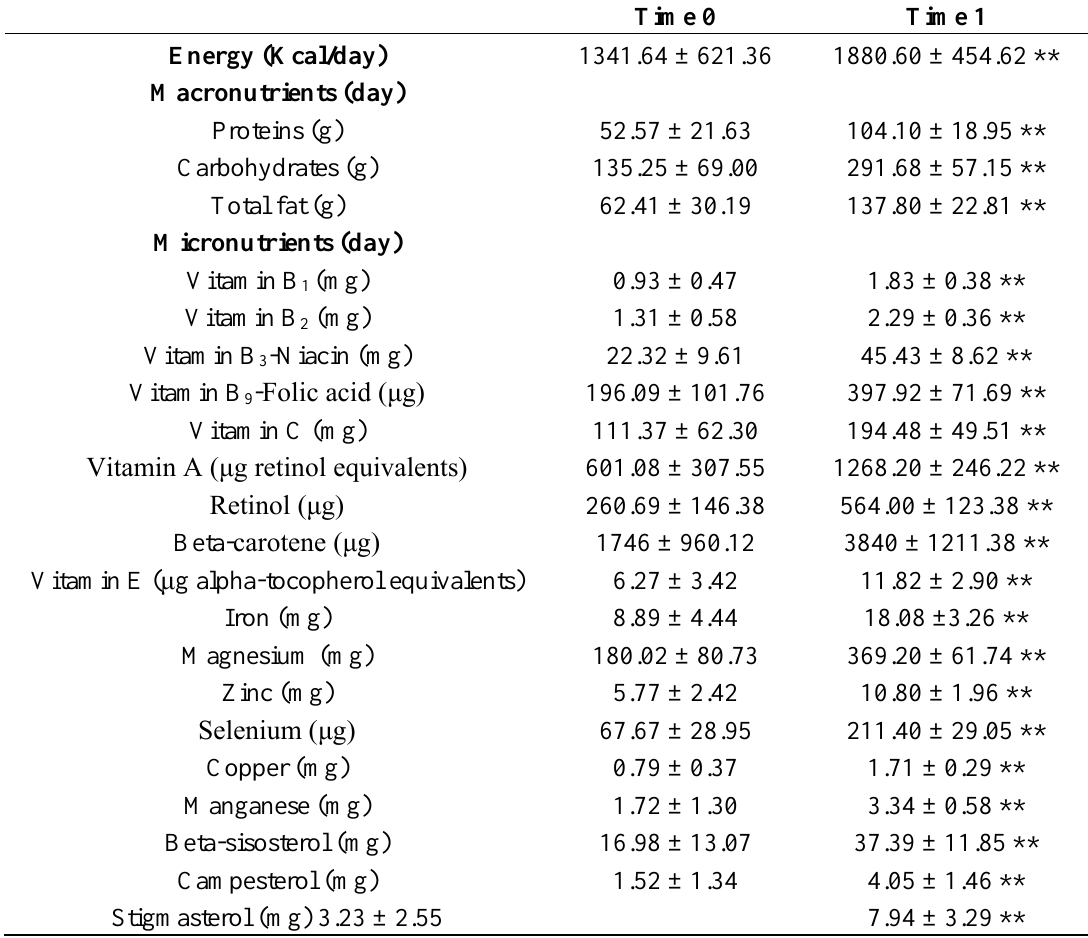
Table 3. Nutrient intake at Time 0 and Time 1 (macronutrients and